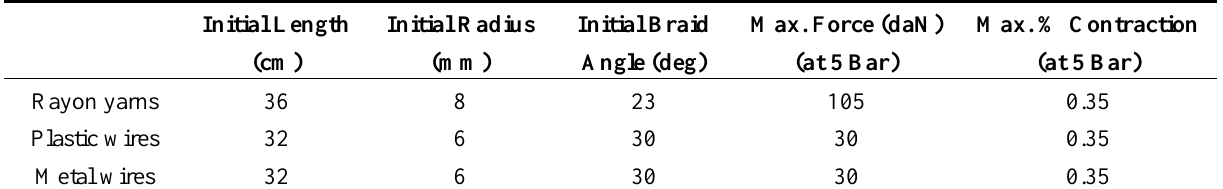
Table 1. Main characteristics of the three considered McKibben artificial muscle